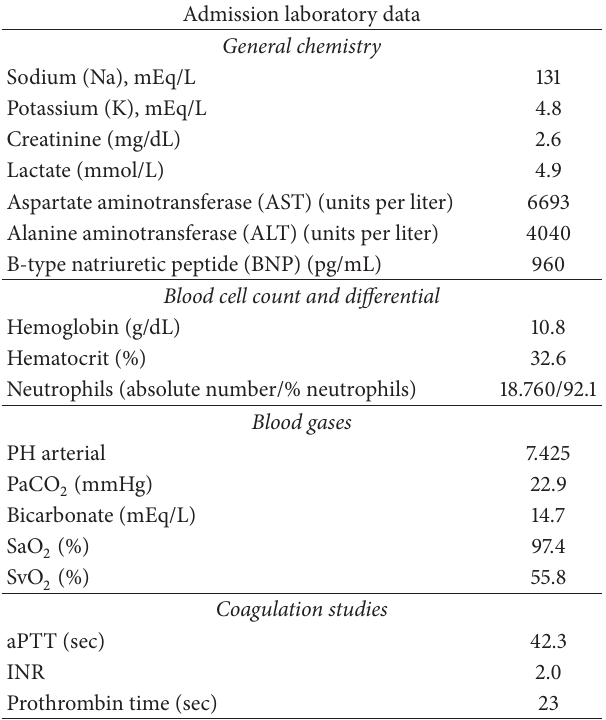
Table 1: Overview of notable admission laboratory